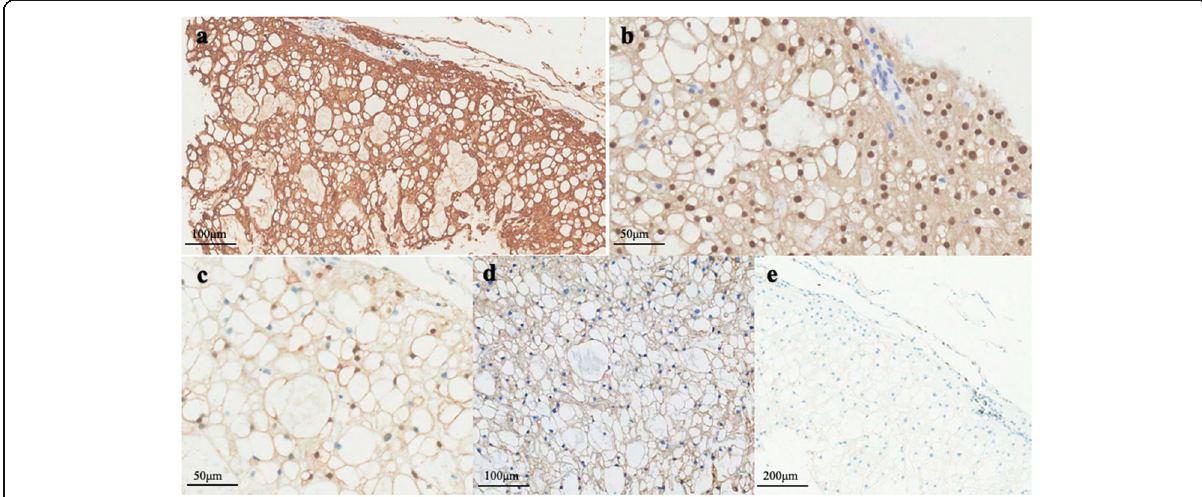
Fig. 3 The tumor cells were positively immunohistochemical staining for CK (AE1/AE3) (a), Brachyury (b), S100 (c), EGFR (d) negatively staining for TTF-1